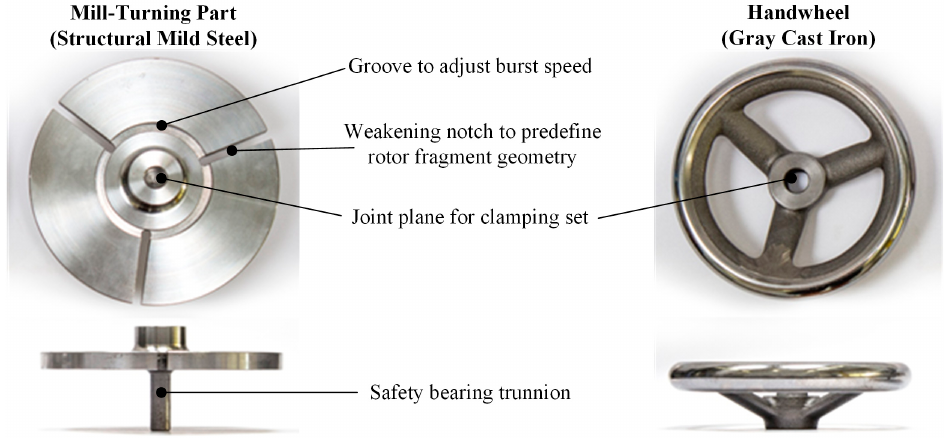
Figure 10. Burst rotors, ( left ) mill-turned part; ( right ) low-cost alternative (cast iron hand wheel).